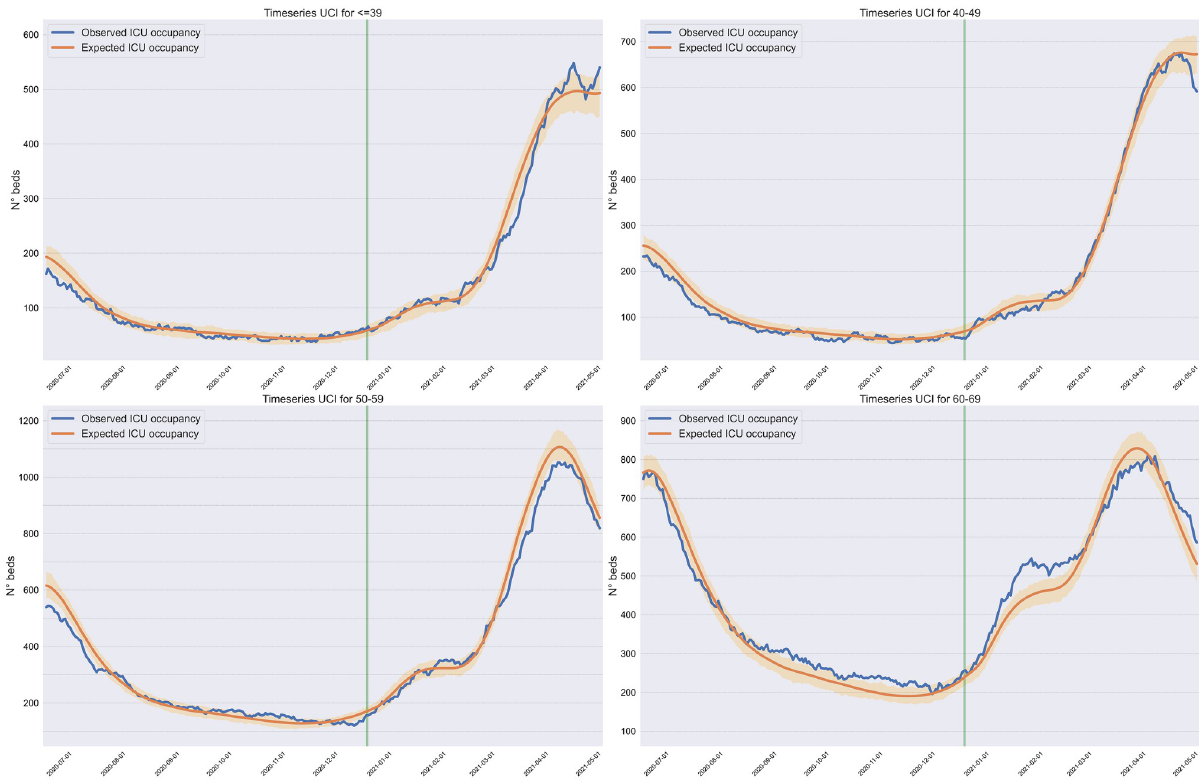
Fig 4. Actual and predicted (expected) ICU occupancy by age during 2020 and 2021, 2021-model. The blue and orange curves depict the observed and predicted (using the 2021-model) ICU occupancy, and the shaded area represents 95% confidence intervals for the expected ICU occupancy. https://doi.org/10.1371/journal.pone.0283085.g004 Table 4. Relative risk estimates (and confidence intervals) by age for ICU admission conditional on infection with the Gamma variant. < = 39